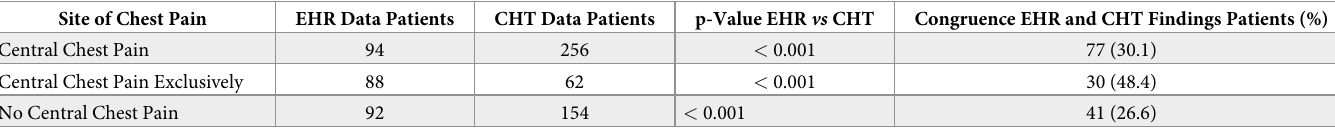
Table 2. Findings for central chest pain in EHR and CHT